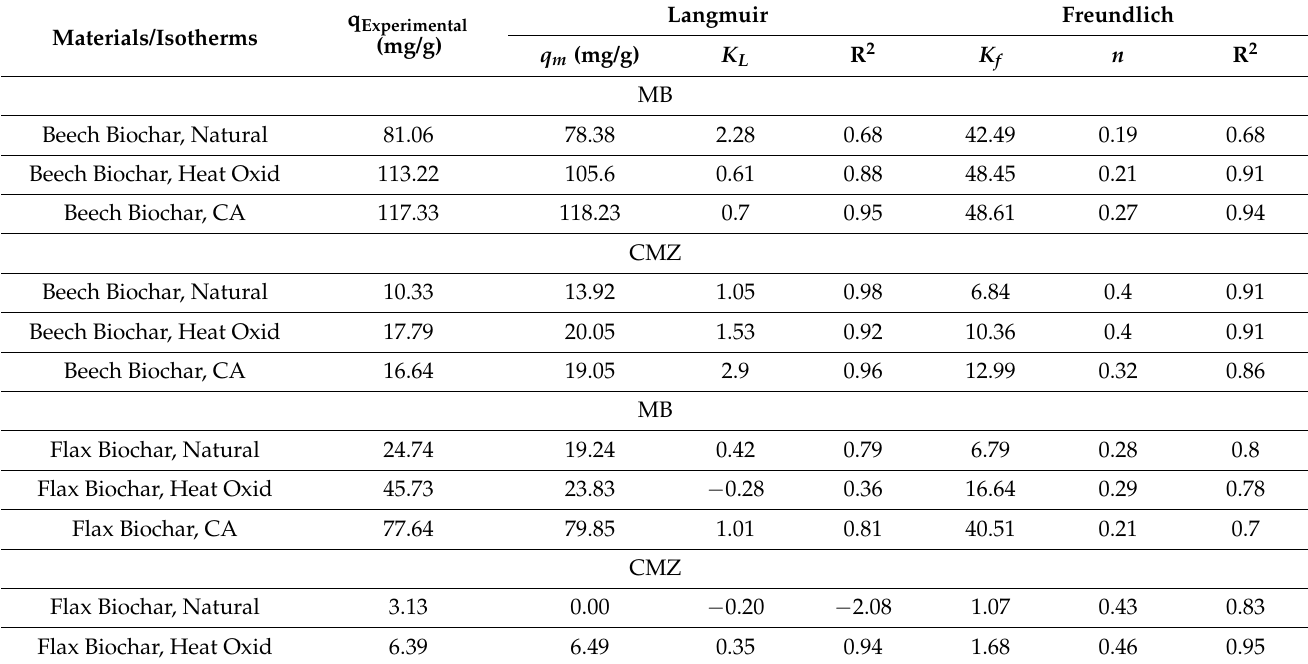
Table 5. Key values of the Langmuir and Freundlich isotherm plots for the adsorption of MB and carbamazepine onto the tested